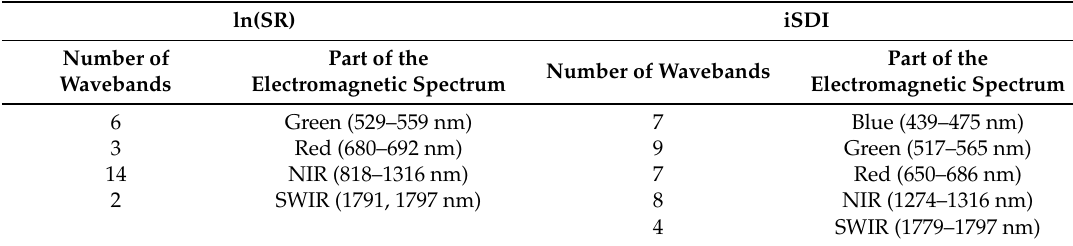
Table A4. Number of important wavebands selected with the help of an iterative variable deletion procedure, for predicting the ln-transformed species richness ln(SR) and the inverse Simpson’s diversity index (iSDI) in grassland plots using the calibration subset ( n =